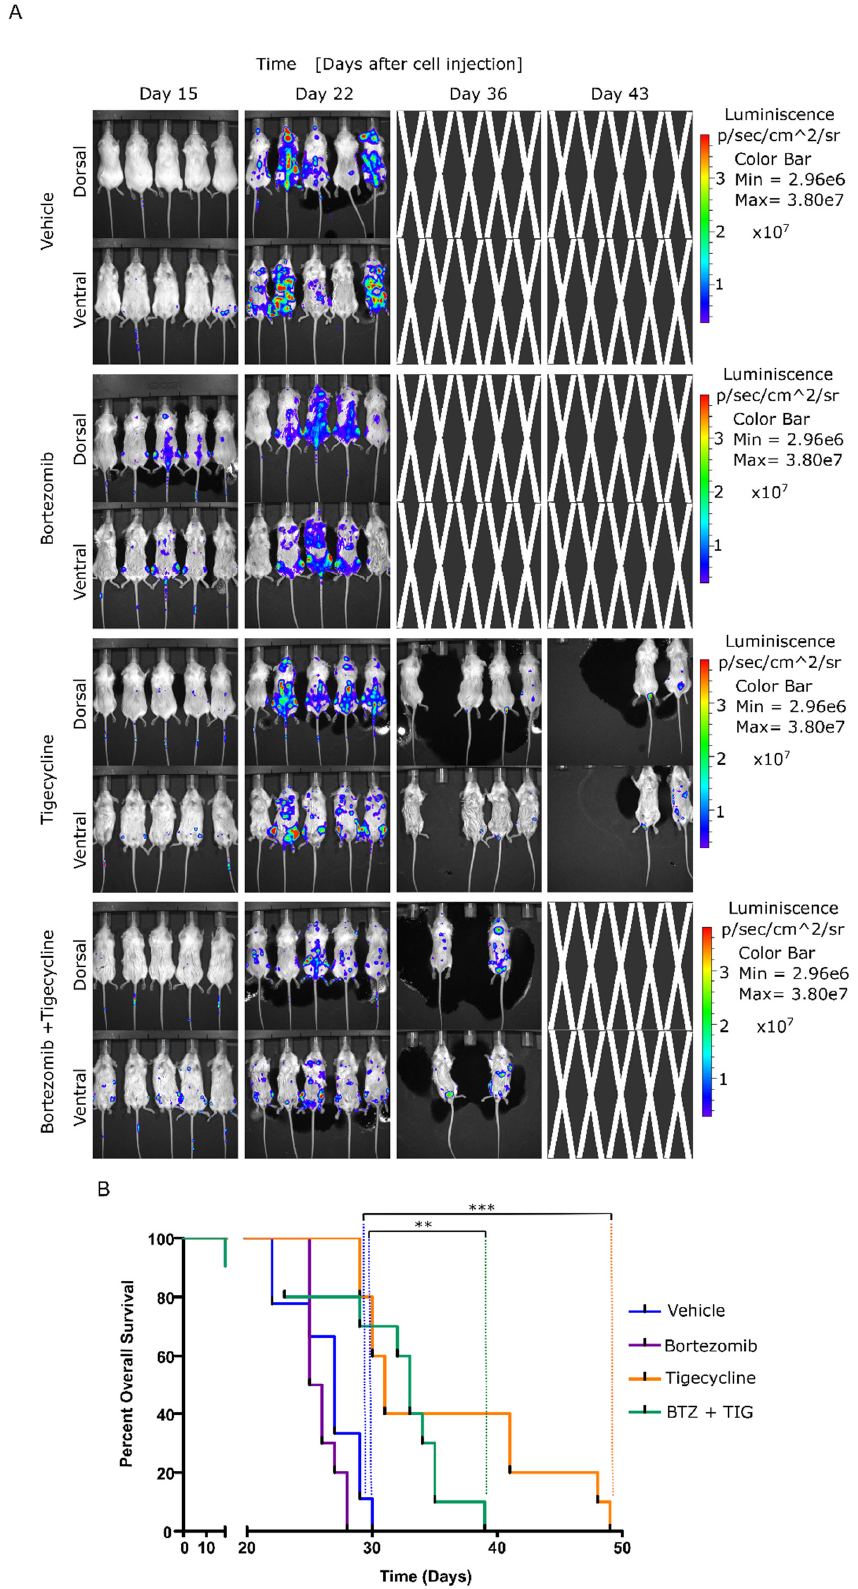
Figure 5. Tigecycline and the combination with bortezomib inhibits cancer cell growth in a MM-xenograft model. ( A ) Bioluminescence images were acquired using an in vivo imaging system. ( B ) Kaplan–Meier survival analysis of mice after the various treatments. ** p < 0.001, *** p < 0.0001 .